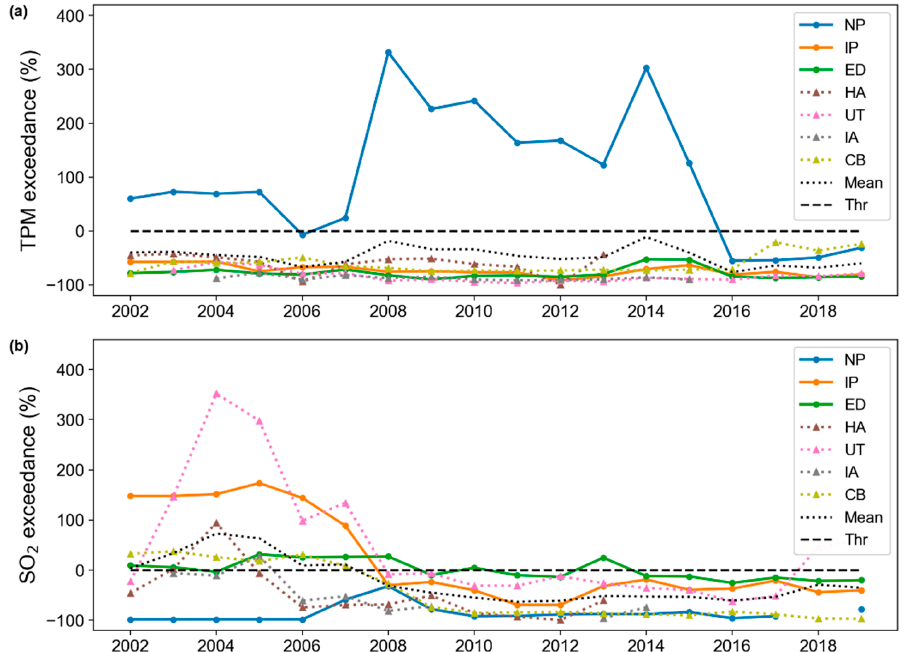
Figure 6. Percentual difference from the ARL on the CPMAEPPF for ( a ) TPM and ( b ) SO 2 . Pulp mills are represented by a solid line and paper mills by a dotted line. The black dotted line represents the mean on all mills and the black slashed line represents when a release equals the threshold suggested by CPMAEPPF.